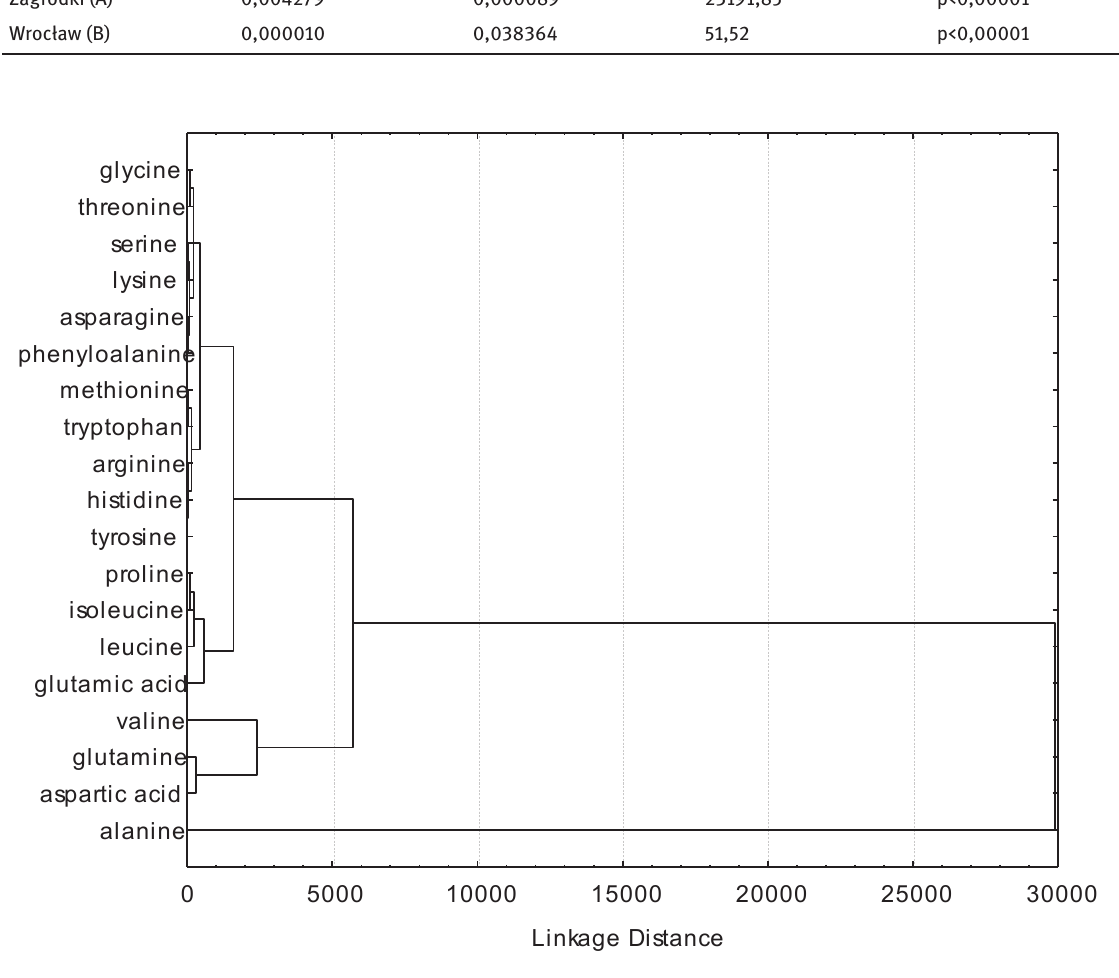
Figure 3: Tree diagram of the cluster analysis for Viola tricolor from 2 habitats.